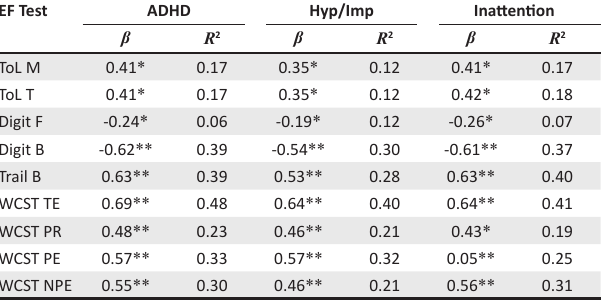
TABLE 3: Relationship between scores of tests for executive function and attention-deficit/hyperactivity disorder domains (DF = 2, 153). EF